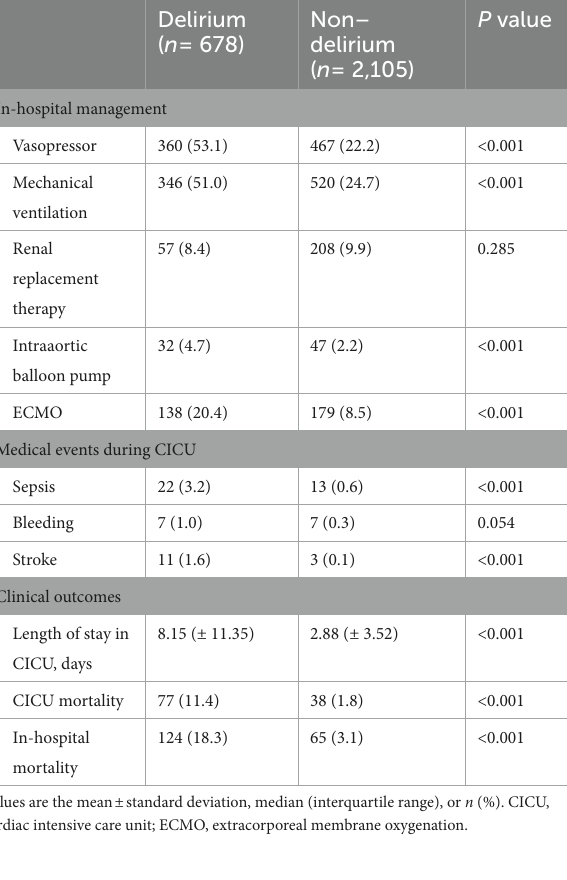
(Table 3). In multivariable analysis, age, sex, smoking, stroke, dementia, Sequential Organ Failure Assessment score, mechanical ventilation, and white blood cell were associated with increased risk of delirium, while albumin level at CICU admission (adjusted OR 0.555; 95% CI 0.402–0.767; p < 0.001) was associated with decreased risk of delirium.